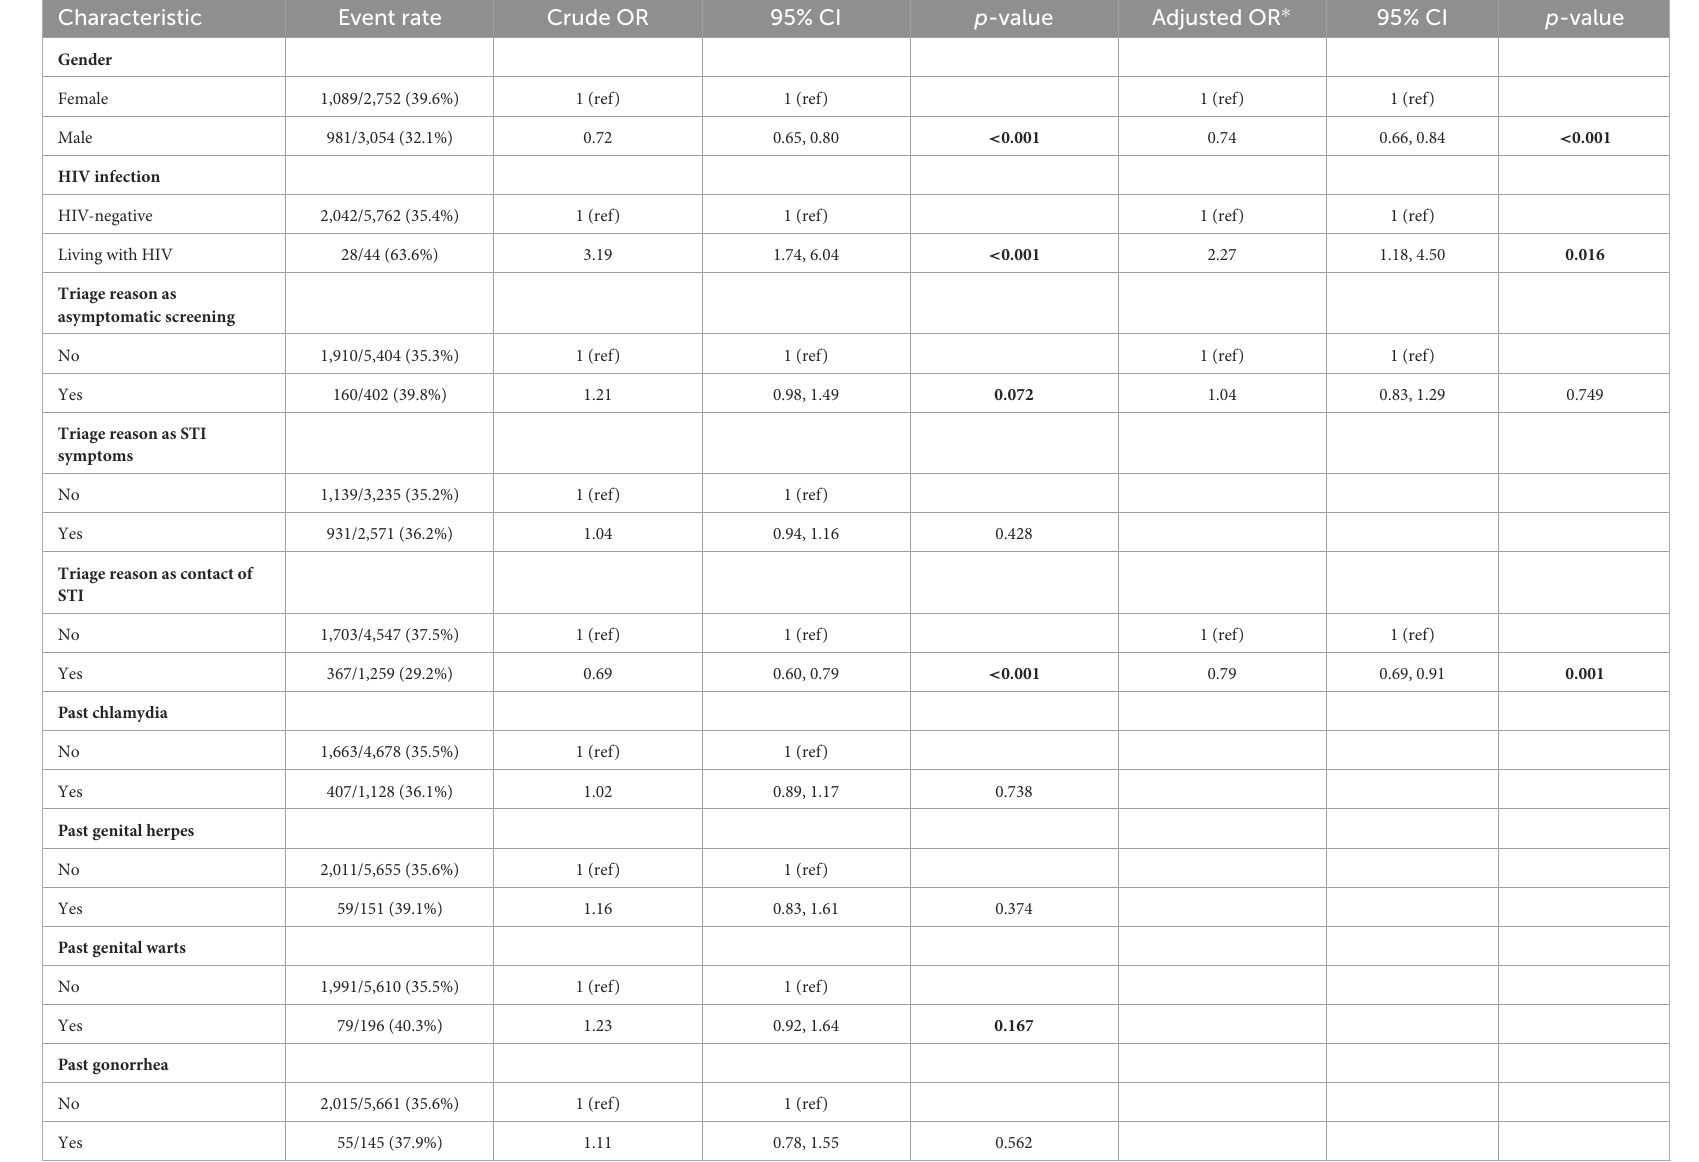
TABLE 1 Factors associated with chlamydia re-testing within 1 year among 5,806 heterosexual individuals with chlamydia. Characteristic Event rate Crude OR 95% CI p -value Adjusted OR ∗ 95% CI p